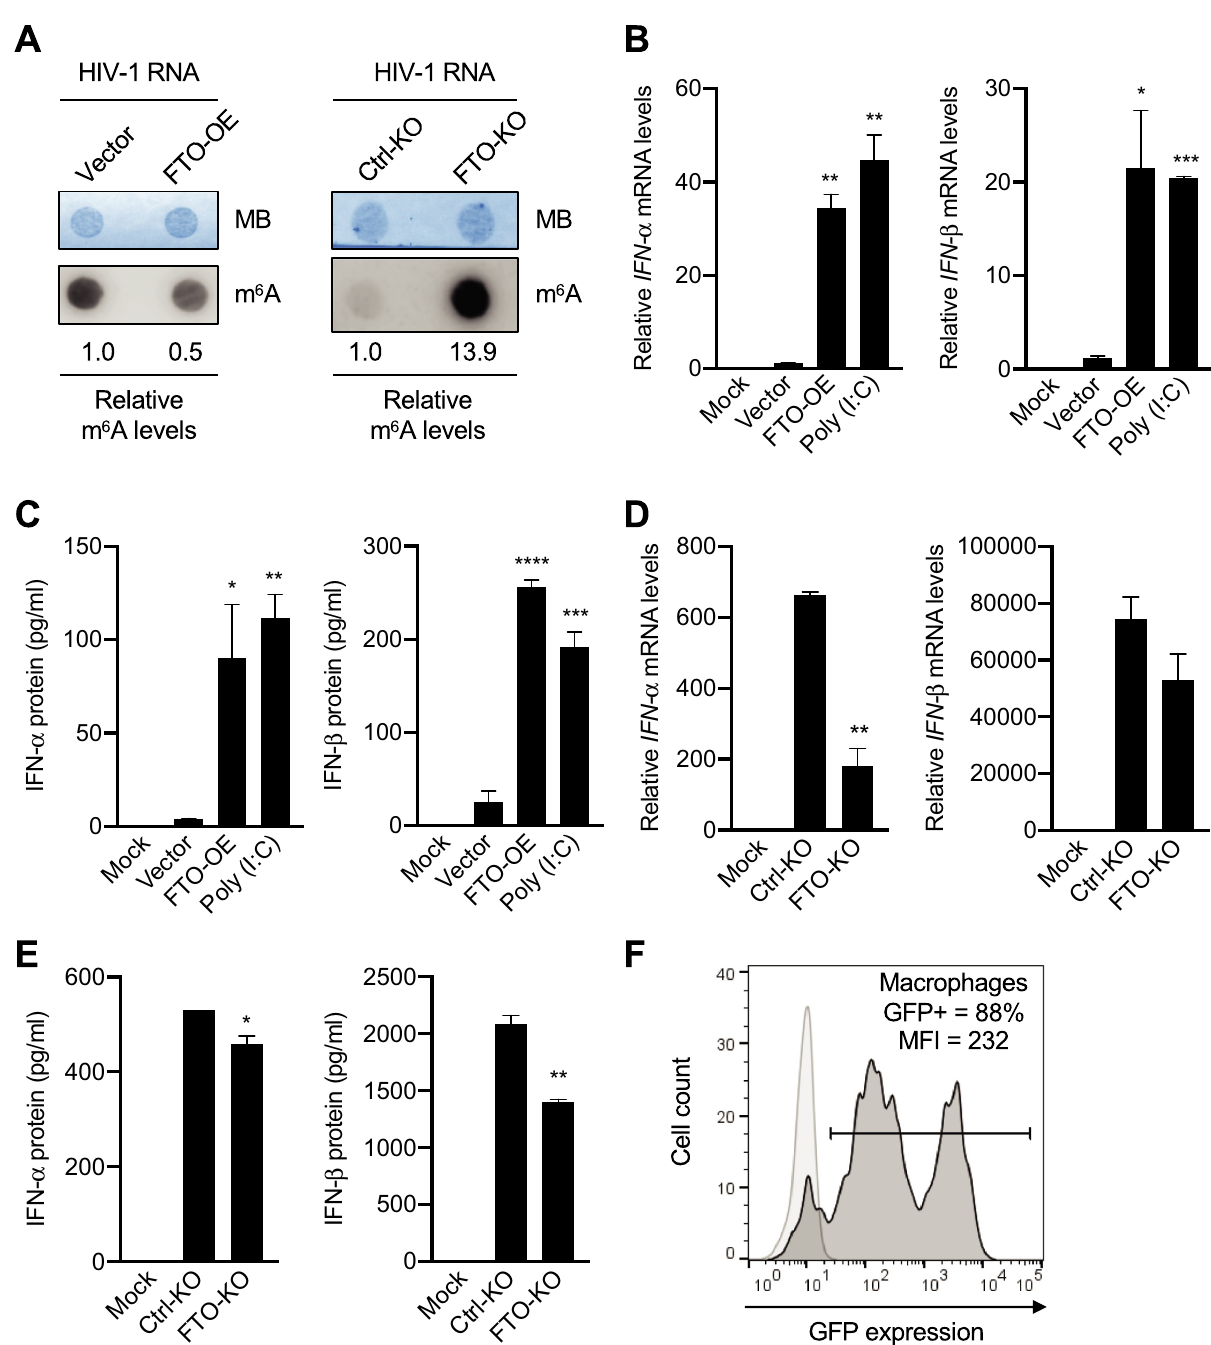
Fig 9. Transfection of m 6 A-altered HIV-1 RNA into primary MDM modulates IFN-I expression. (A) m 6 A levels of HIV-1 RNA (100 ng) of virions generated from vector control HEK293T cells, FTO-overexpressed HEK293T cells (FTO-OE), control-KO HEK293T cells (Ctrl-KO), or FTO-KO HEK293T cells were measured by dot-blotting. Methylene blue (MB) staining was used as an RNA loading control. (B-E) MDM (5 × 10 5 ) were mock- transfected (no RNA) or transfected with 125 ng isolated HIV-1 RNA or poly (I:C) as indicated. At 24 hr post-transfection, (B and D) IFN-I mRNA levels in MDM were measured by qRT-PCR. (C and E) IFN-I protein levels in the supernatants of transfected MDM were detected by ELISA. These experiments were repeated three times with MDM from three different donors. Data shown were from one representative experiment with means ± S.D. of three biological repeats. Un-paired t-test was used for statistical analysis. � P < 0.05, �� P < 0.01, ��� P < 0.001, ���� P < 0.0001 compared to the indicated controls (B-C, compared to the vector control; D-E, compared to the Ctrl-KO). (B-E) IFN-I levels in mock samples were undetectable and used as a